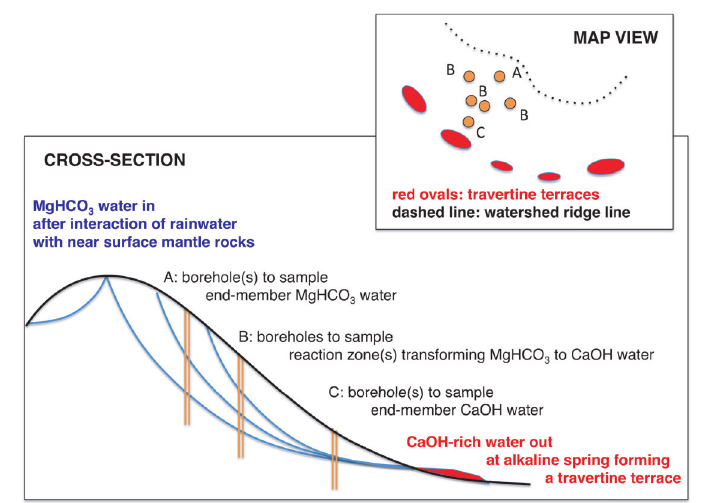
Figure 1. Schematic illustration of planned array of boreholes designed to locate and sample input fluid, the subsurface reaction zone, and output fluid in a site of ongoing peridotite weathering and low temperature